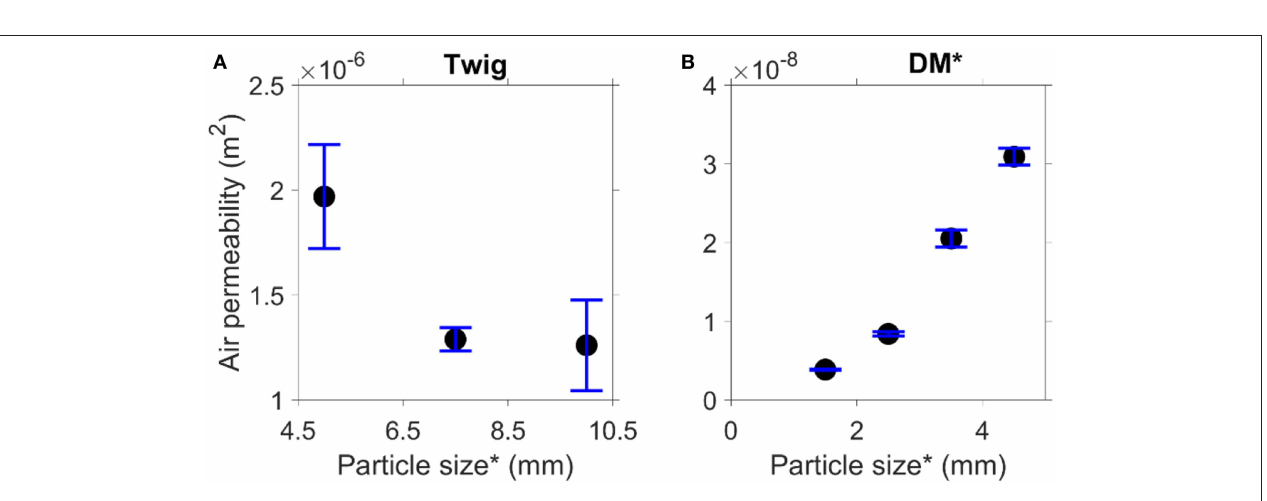
FIGURE 13 | Permeability (k) as a function of particle size (*Average sieve opening size) (A) twig, (B) decomposing matter